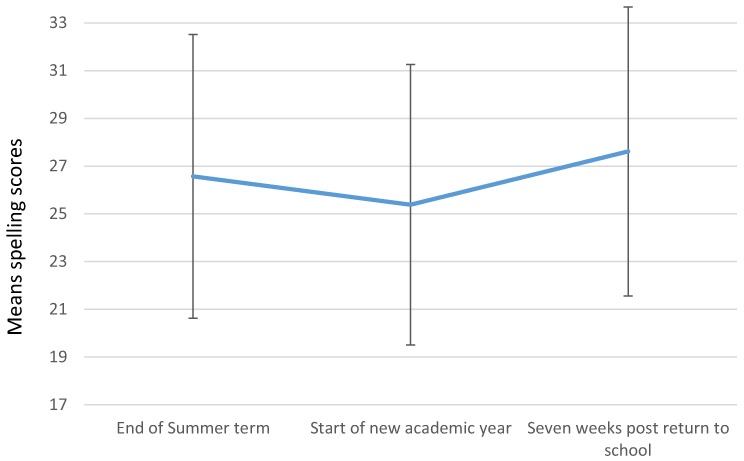
Mean spelling scores as a function of time.